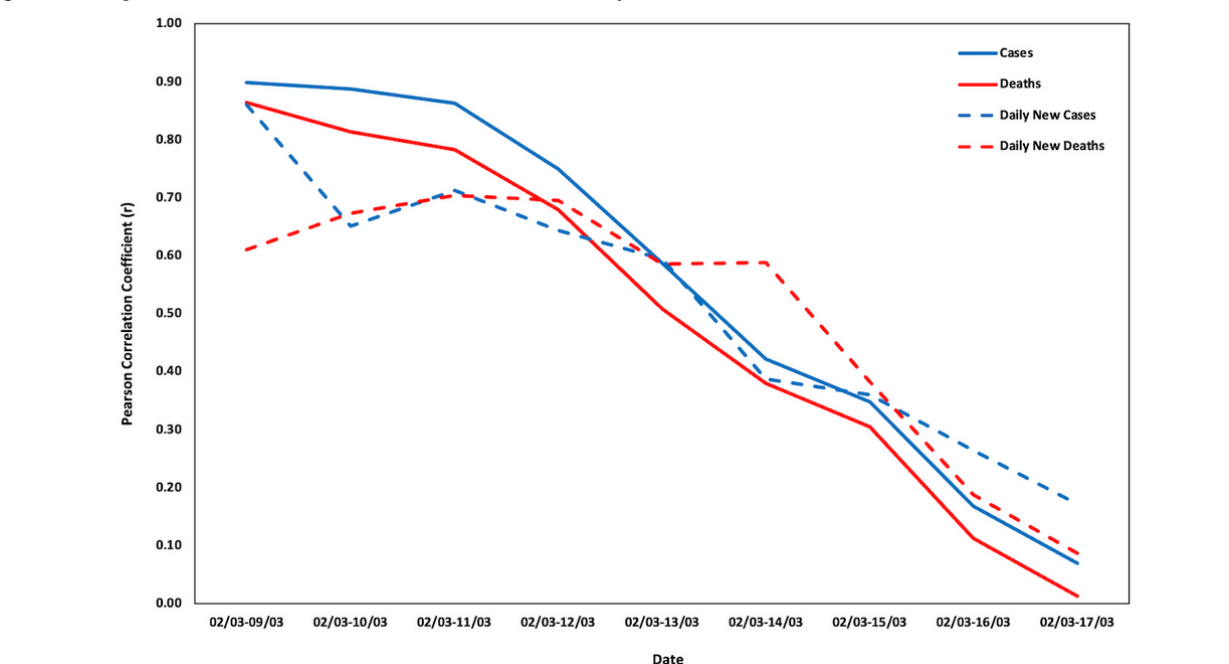
Figure 5. Changes in the Pearson correlation coefficients ( r ) for